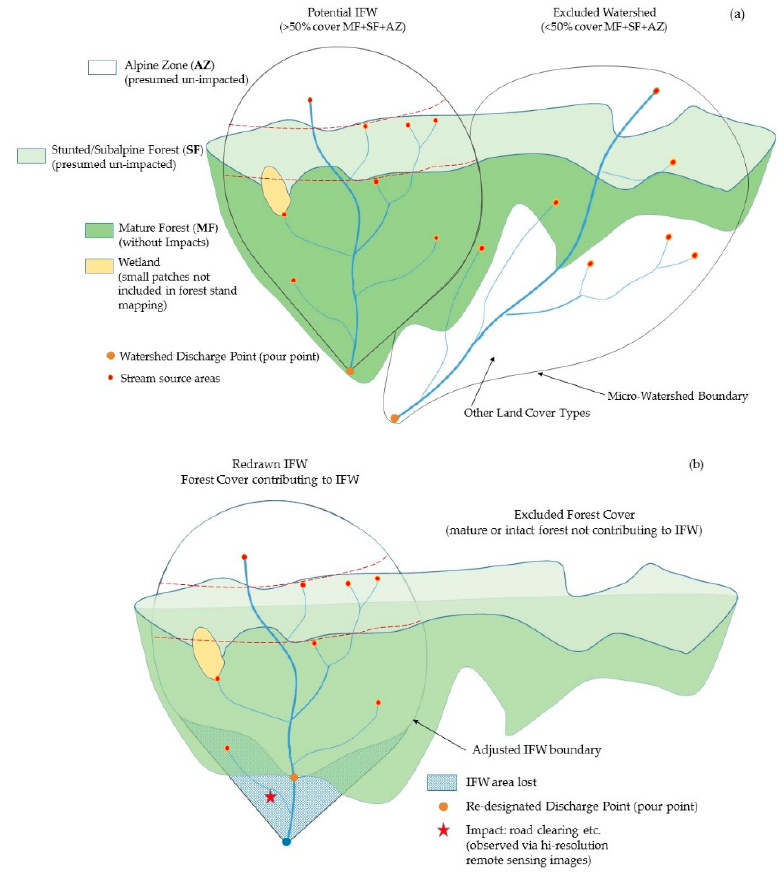
Figure 3. Mapping and decision criteria for Intact Forested Watersheds: ( a ) IFW designation and forest contribution for regional analysis; ( b ) IFW adjustment following basin scale analysis.